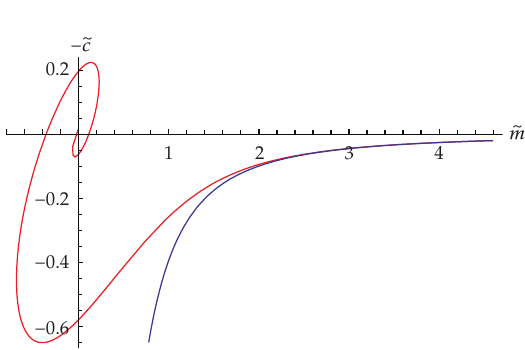
Figure 7: A plot of − (cid:5) c versus (cid:5) m . At zero bare mass (cid:5) m (cid:8) 0, the theory has developed a negative condensate (cid:3) ψψ (cid:4) ∝ − (cid:5) c ≈ − 0 . 59. For large (cid:5) m , there is an excellent agreement with (cid:3) 4.104 (cid:4) , as represented by the lower cr (cid:3) blue (cid:4)